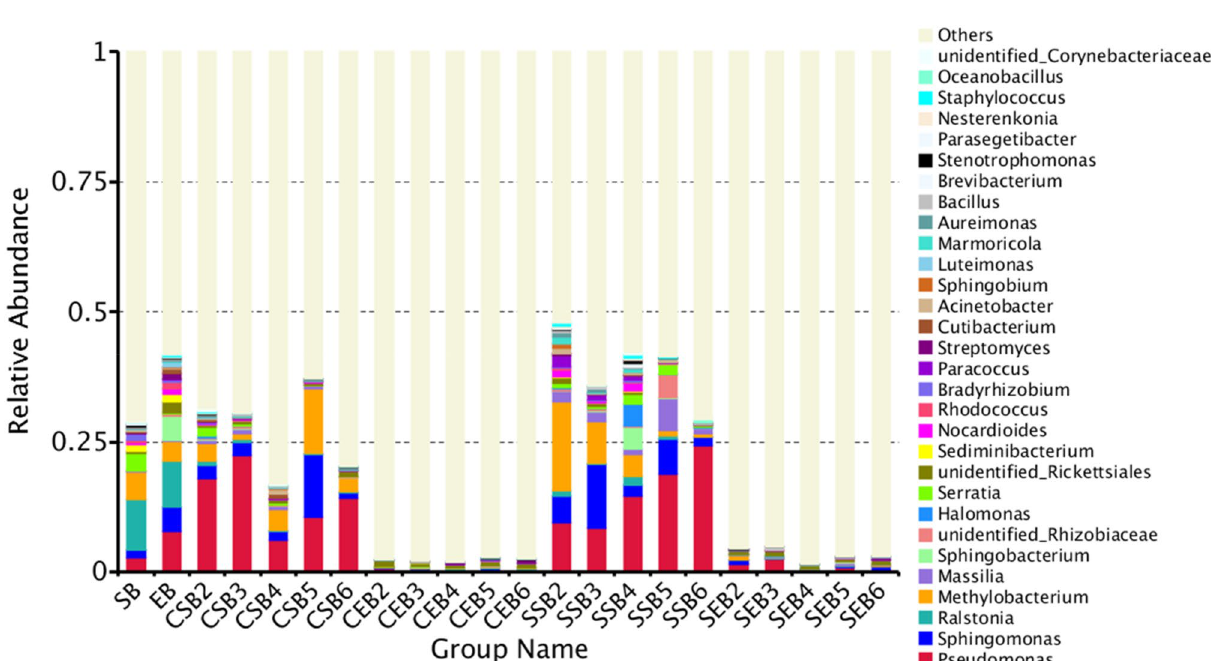
Figure 6. Column chart of species relative abundance at genus